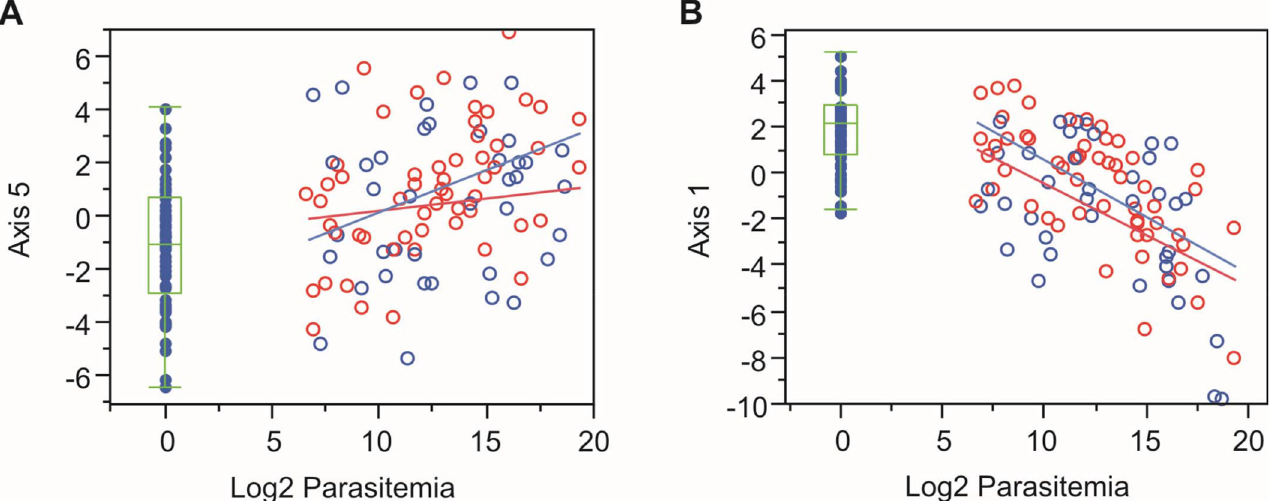
Fig 7. Log2 Parasitemia and Axis 2 and 5 Benin Study, West Africa. Significant correlation is evident between parasitemia and axis of variation, even though unrelated to location. A. Axis 5, r = 0.20, p = 0.0079. B. Axis 1, r = -0.47, p = 1.4×10 -9 . Neither interaction effect is significant, indicating that the correlation is similar in both locations. Each plot shows the correlation between location and axis of variation, blue represents samples from Cotonou, red represents samples from Zinvié; solid points represent control and open circles represent malaria